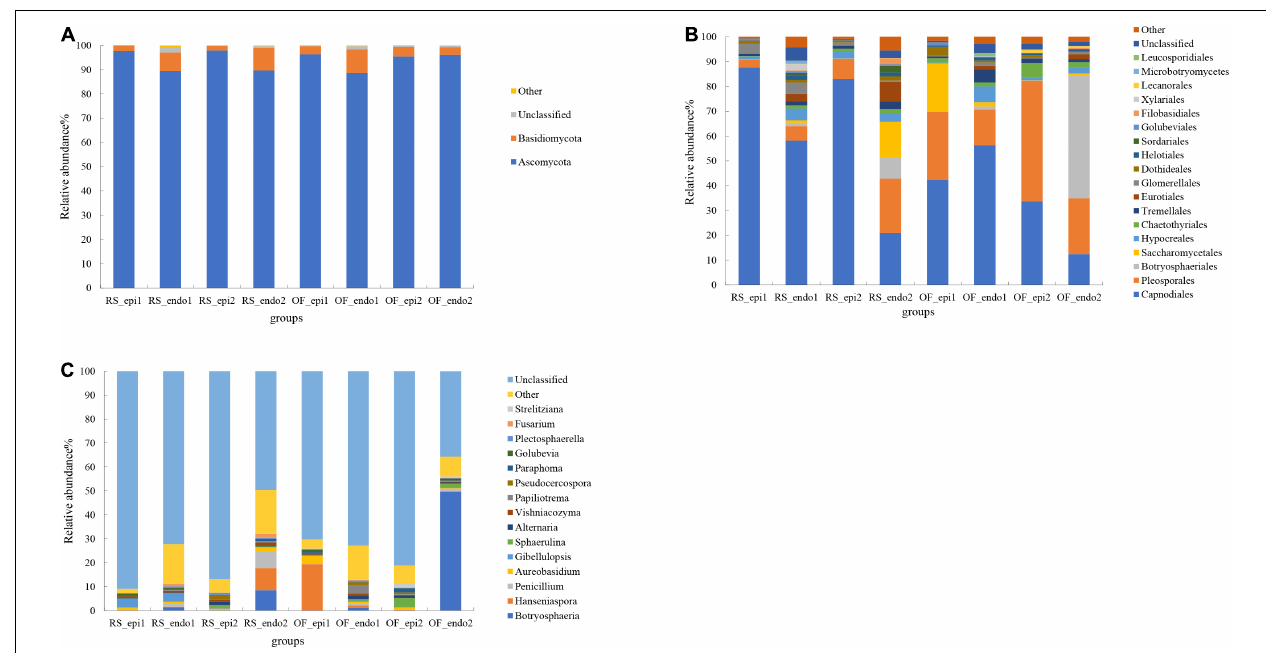
FIGURE 2 | Relative abundance of fungal taxa at the level of phylum (A) , order (B) , and genus (C) . The fungal taxa with a relative abundance < 1% were grouped together and are designated as “Other.” Samples labeled "RS" and "OF" designate rain-shelter (RS) and open-field (OF) samples, respectively. The terms "epi" and "endo" designate epiphytic and endophytic sample groups, respectively, and the designations "1" and "2" indicate “Hongyang” and “Cuiyu” cultivars, respectively. The samples were taken in September 2019.